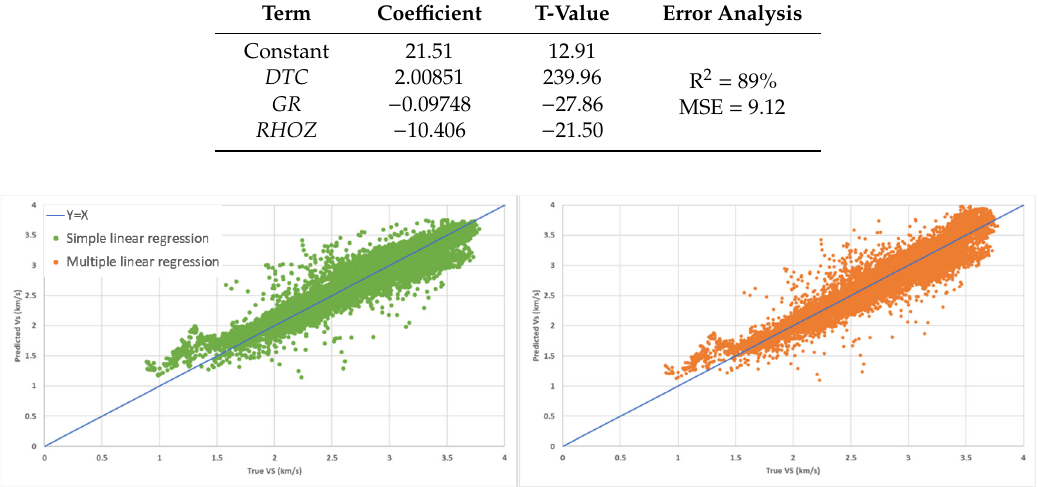
Figure 6. Predicted vs. True shear velocity for Well ‐ 2 using ( left ) Simple linear and ( right ) multiple linear regression methods from Well ‐ 3.